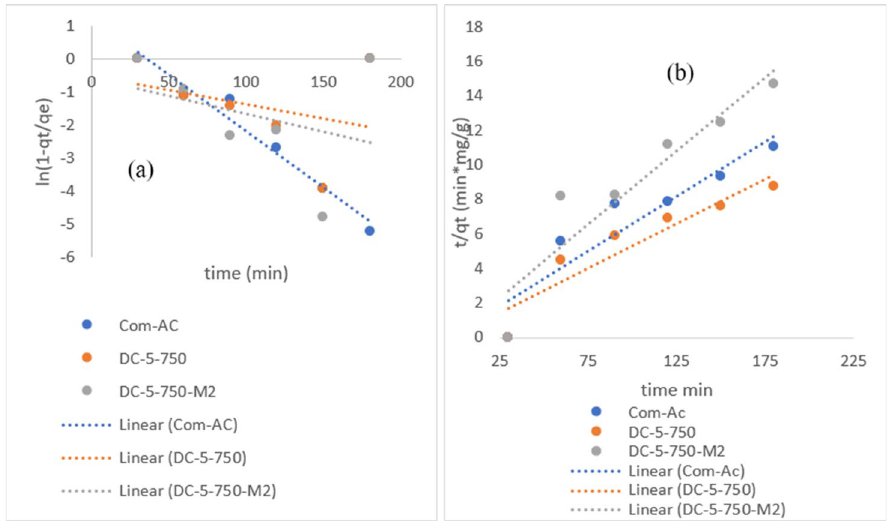
Figure 17. nitrate PSO ( a ) and PFO ( b ) kinetic models plots.